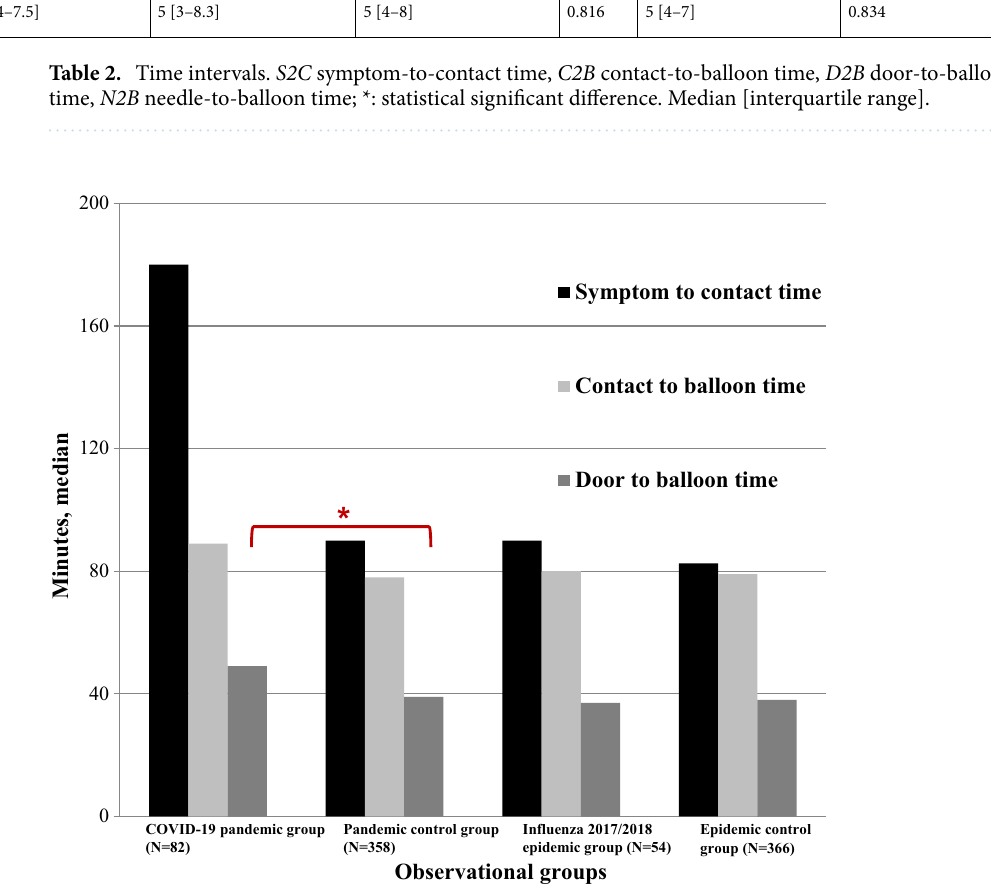
Figure 1. Treatment delay until